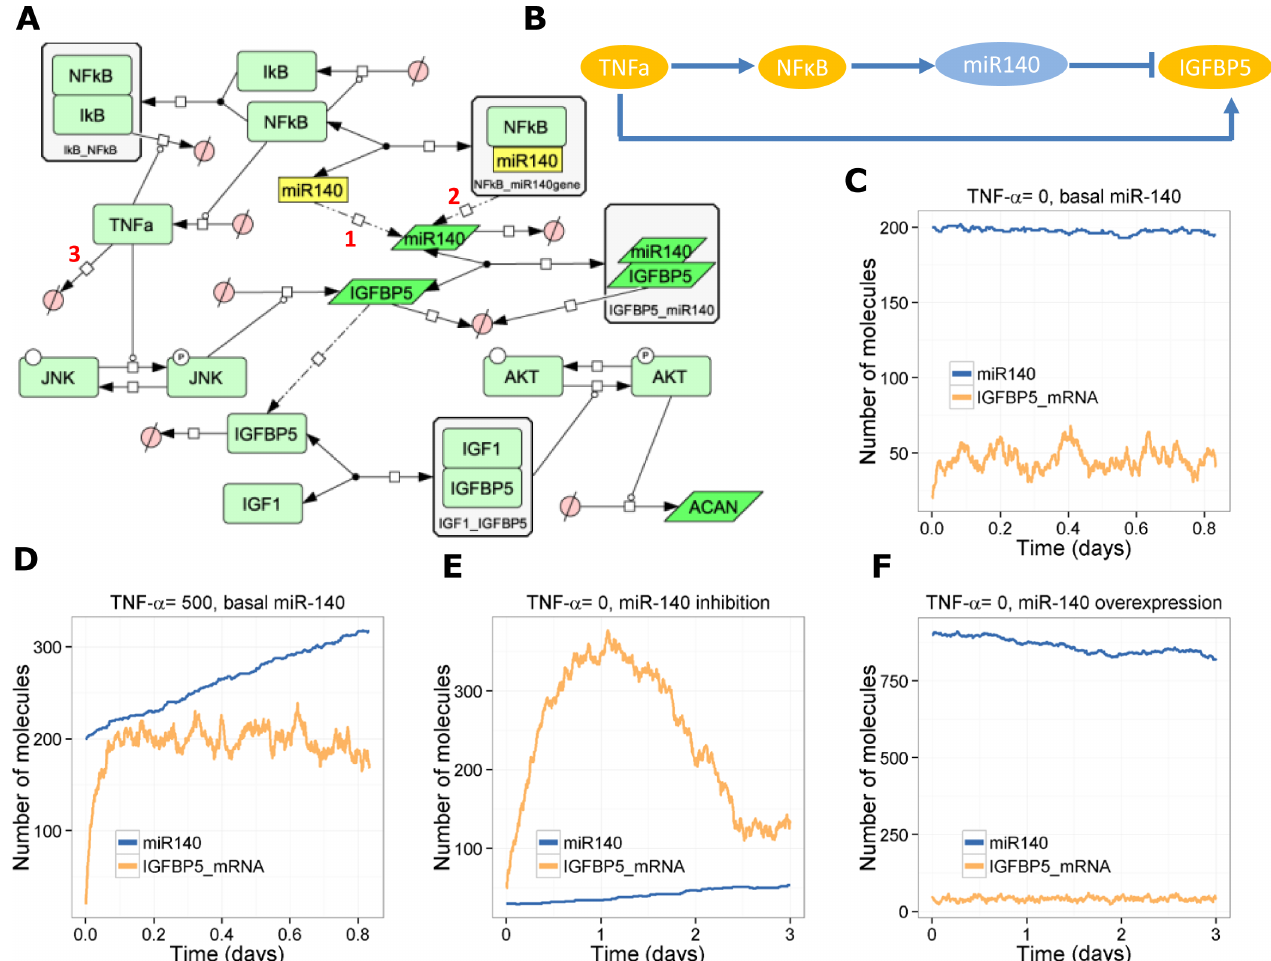
Fig 6. Model of the interaction between miR-140, IGFBP-5 and TNF- α . A, Diagramof full model; B , Network motif showingincoherent feedforward loop. C - F , Output from one stochastic simulationshowingtotal pools of miR-140and IGFBP5 mRNA, C ,TNF- α = 0; D , TNF- α = 500; E , TNF- α = 0, miR-140inhibition(miR140= 30 initially, k synmiR140 = 6e-5 s -1 , k synmiR140NFkB = 1.5e-4 s -1 ); F , TNF- α = 0, miR-140overexpression (miR140= 900 initially, k synmiR140 s -1 = 0.0018, k synmiR140NFkB = 0.0045 s -1 ).